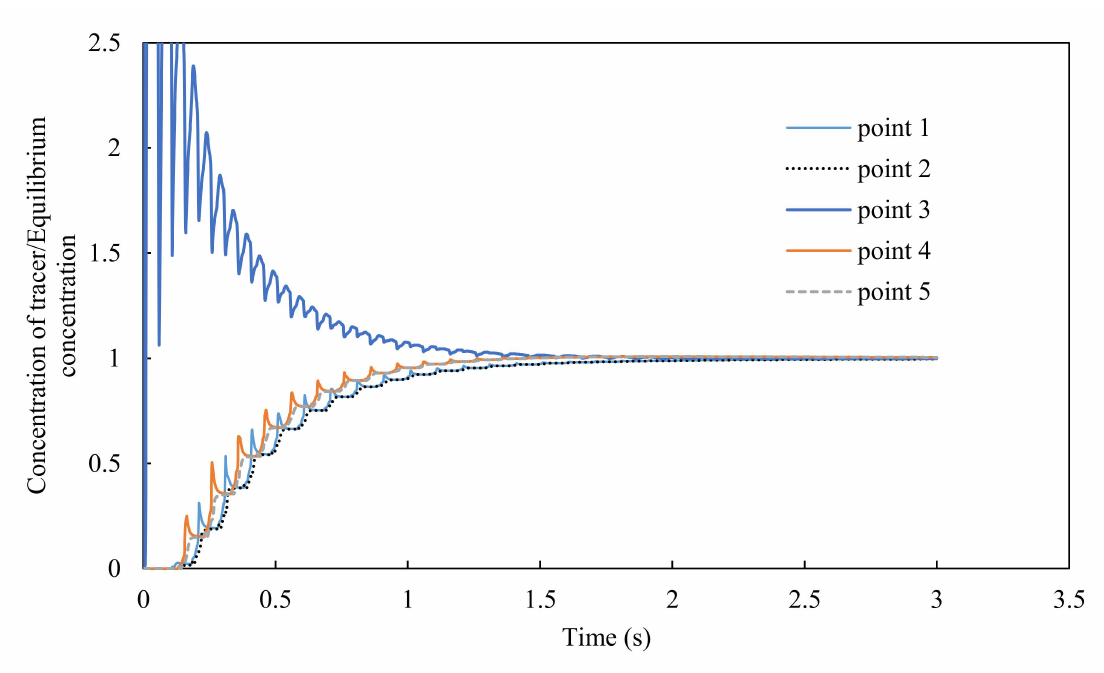
Figure 8. The ratio of the concentration of the tracer to equilibrium concentration against time in points 1 to 5 (oscillation frequency = 10 Hz, oscillation amplitude = 40